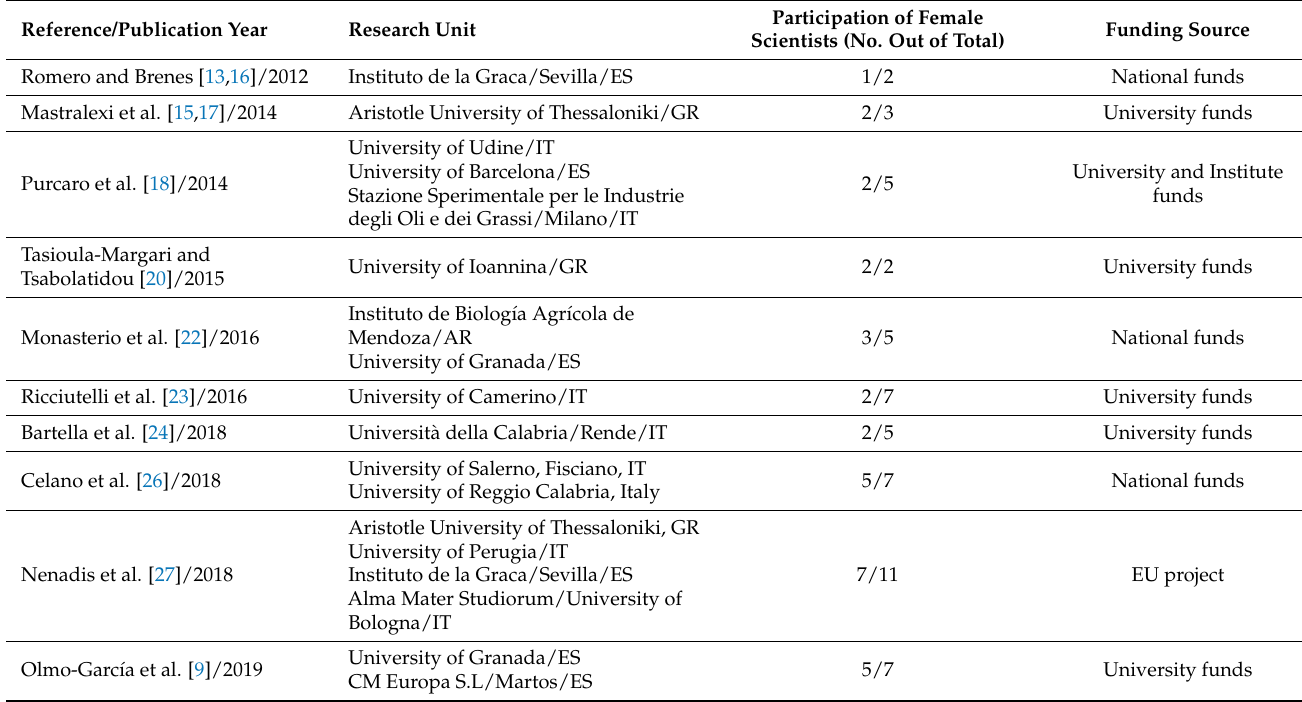
Table 2. Dedicated separation protocols on the implementation of the health claim on ‘olive oil polyphenols’ (EC Regulation 432/2012) in chronological